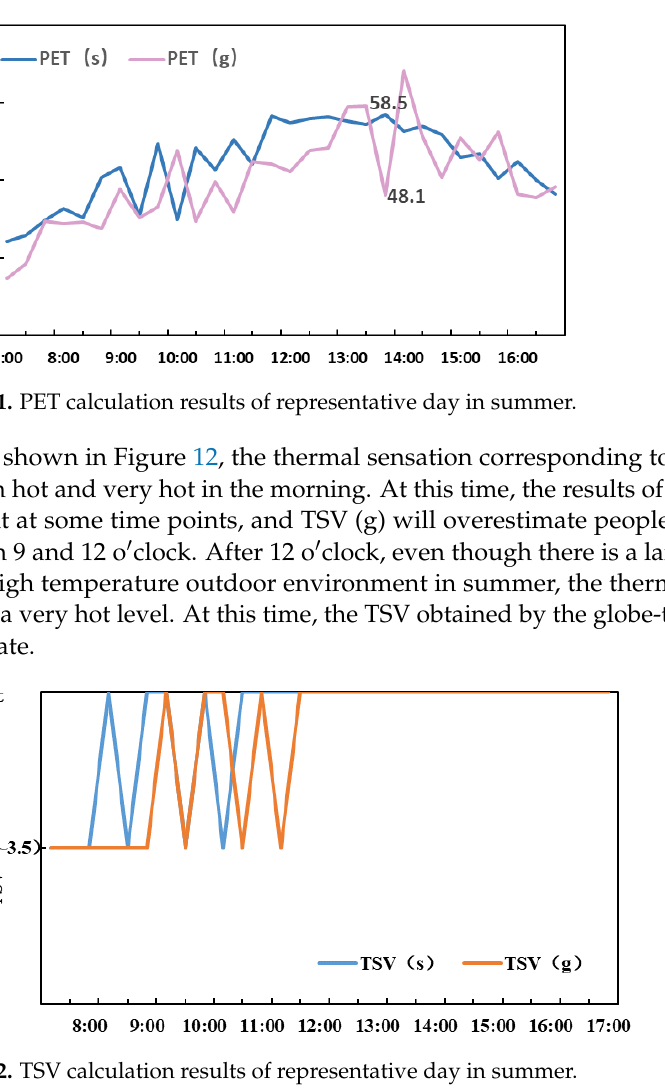
Figure 13. PET calculation results of representative day in transition season. The shaded part in the figure indicates the time period when the gap between PET(s) and PET(g) is obvious The thermal sensation data correspond to Figure 14 and show that people′s thermal sensation is slightly warm in the whole day under TSV (s) results; TSV (g) underestimates thermal sensation as neutral before 9 a.m. and overestimates thermal sensation as warm in a small number of times in the afternoon; and the results of other times are consistent